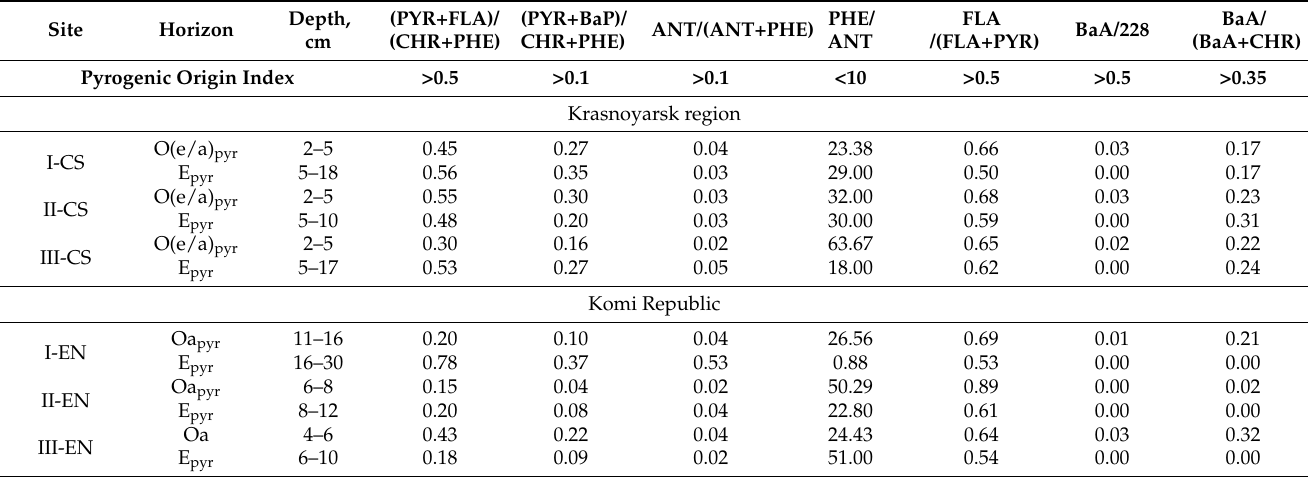
Table A2. Diagnostic ratios of individual PAHs in